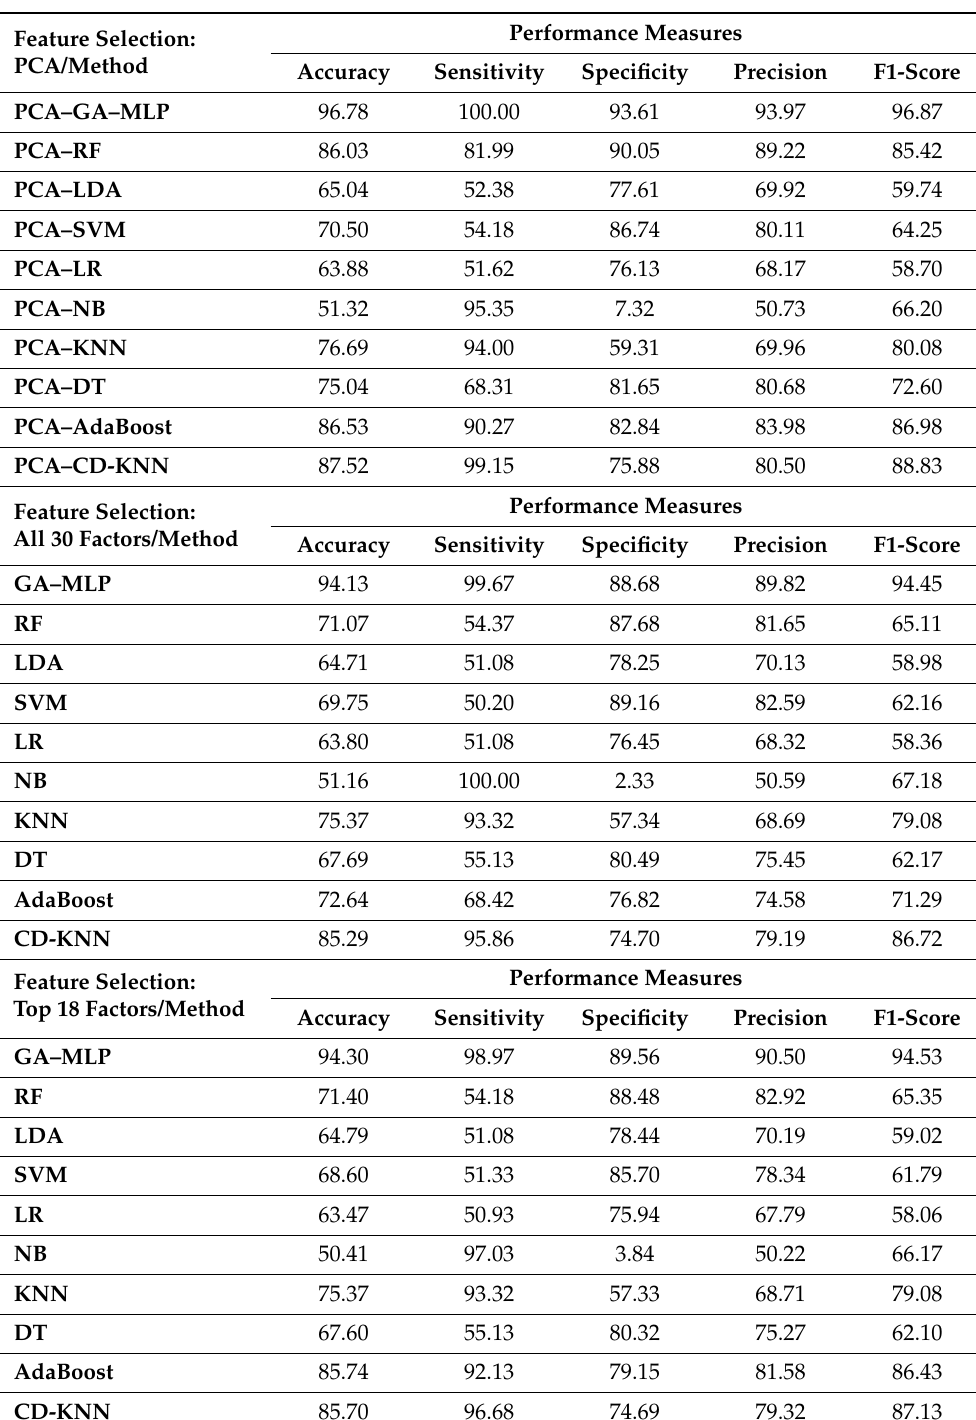
Table 7. Comparison of the proposed method using four feature selection methods with nine other classification algorithms in diagnosing